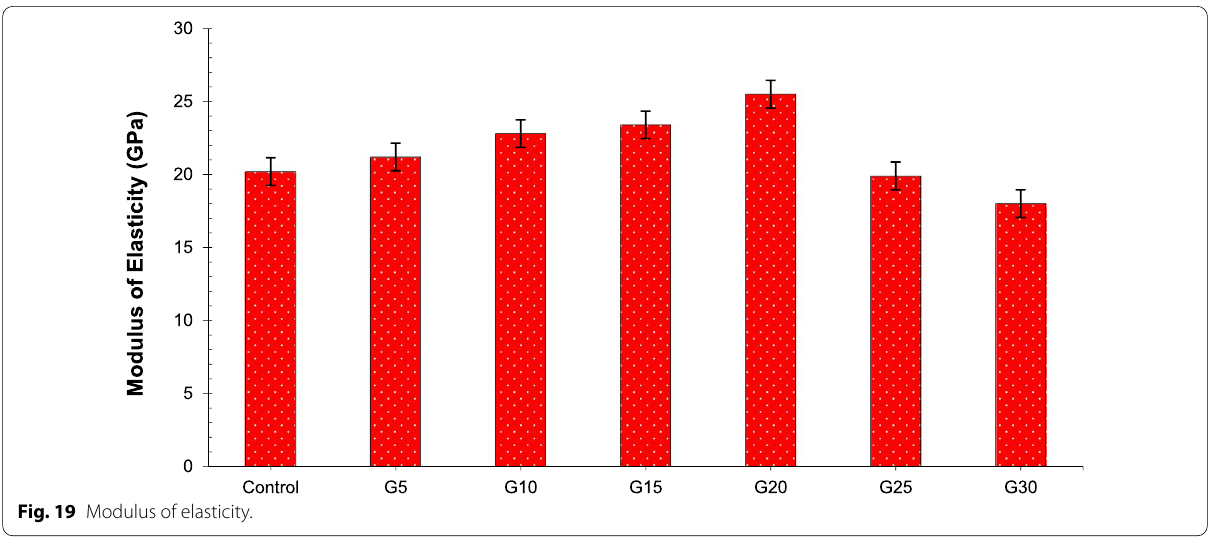
Fig. 19 Modulus of elasticity.